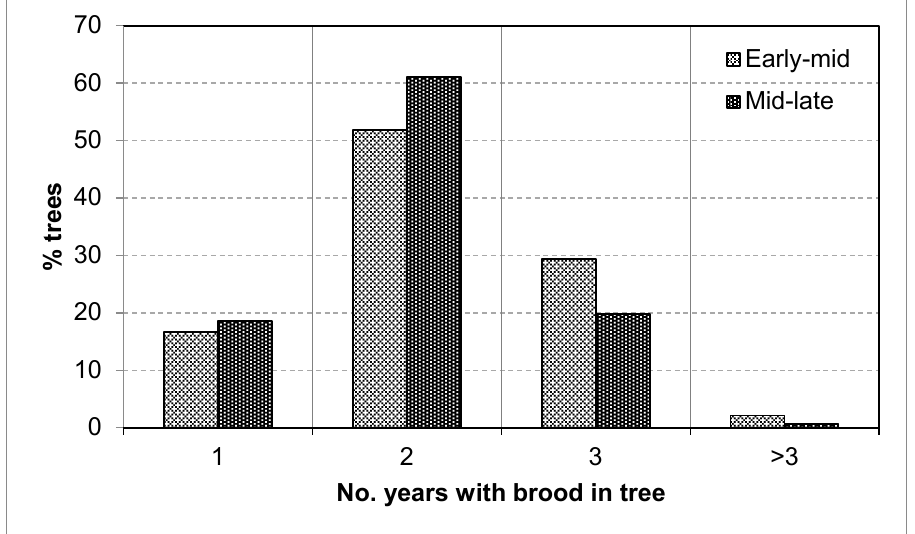
Figure 4. The percentage of D. confusus attacked subalpine fir, by phase (early-to-mid phase or mid-to-late) that contained live brood (eggs, larvae, pupae, adults) or beetle emergence after one year, two years, three years, or more than three years in seven plots.